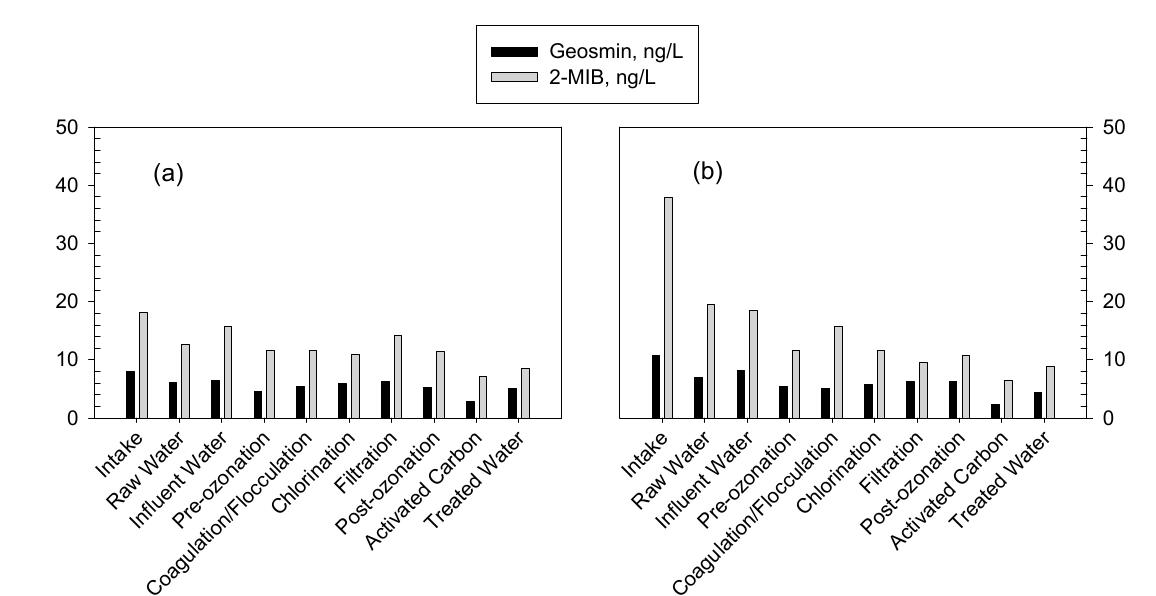
Figure 8. Water quality change affected by unit treatment processes at different operation times. ( a ) day-time and ( b ) night-time.